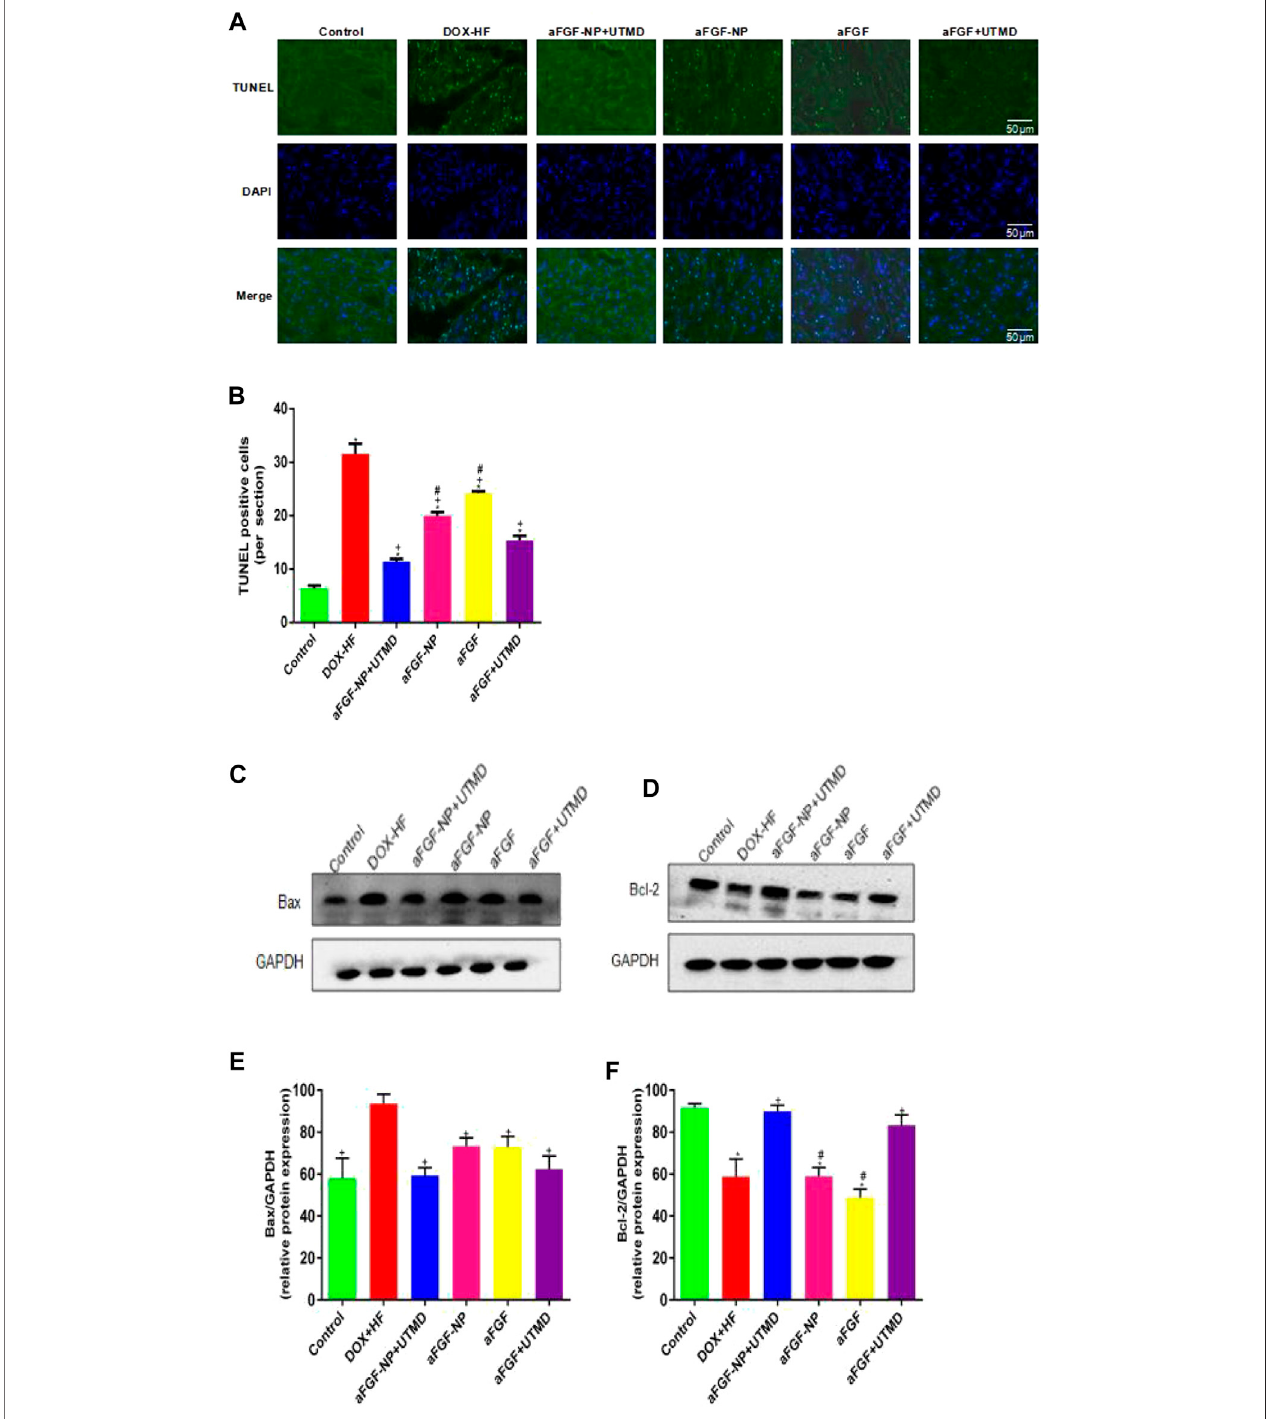
FIGURE 5 | The aFGF – NP + CPMBs combined with UTMD inhibited cardiomyocyte apoptosis in DOX – HF rats. (A) : Representative photos of TUNEL staining in each group(400x); (B) : Quantitative analysis of the apoptotic cells. The protein expression of Bax and Bcl – 2 in myocardial tissue was detected by Western blot. (C, D) RepresentativephotosofWesternblot; (E,F) StatisticalanalysisoftheproteinexpressionofBaxandBcl – 2.Alldataareexpressedasmean ± SEM.* p < 0.05vs.Control group; + p < 0.05 vs. DOX – HF group; # p < 0.05 vs. aFGF – NP + UTMD group. aFGF, acidic fi broblast growth factor; NP, nanoparticles; CPMBs, cationic lipid microbubbles; UTMD, ultrasound targeted microbubble destruction; DOX, doxorubicin; HF, heart failure. Prevention the decreation of myocardial capillary density in DOX – HF.